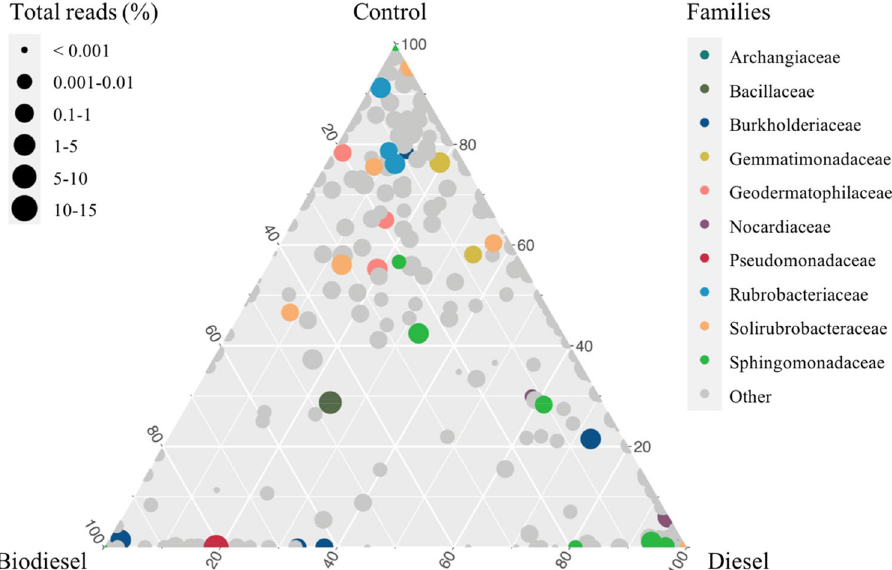
Figure 5. Ternary plot representing the relative occurrence of bacterial genera (circles) in soils under three different treatments (control, diesel and biodiesel). Genera enriched in different treatments are colored at family level and circle size is proportional to their abundance in the community. This figure was generated using the ‘ggtern’ package in